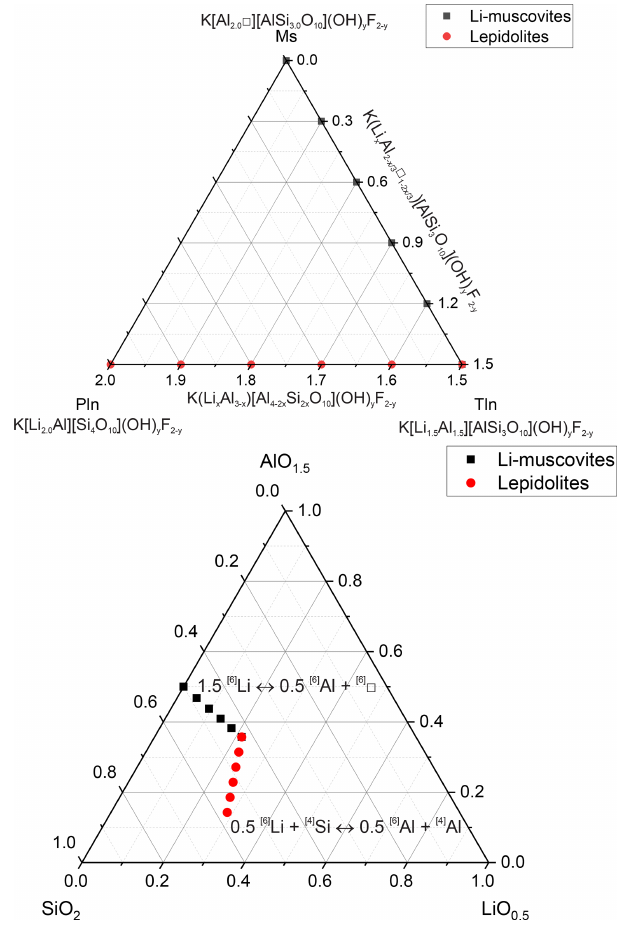
Figure 1. Phase diagram of the dioctahedral muscovite, the trioc- tahedral trilithionite and the trioctahedral polylithionite and ternary diagram in terms of oxides showing the compositions of the samples used in the